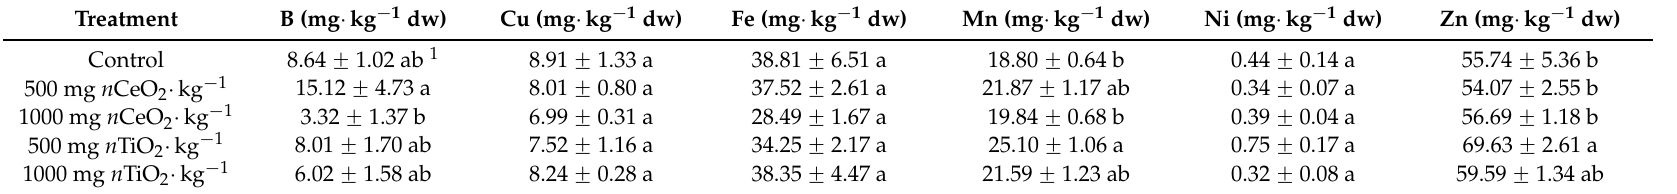
Table 7. Concentration of micro-nutrients in barley kernels at ripening from main shoot grown in soil treated with none (control), 500 mg n CeO 2 ¨ kg ´ 1 , 1000